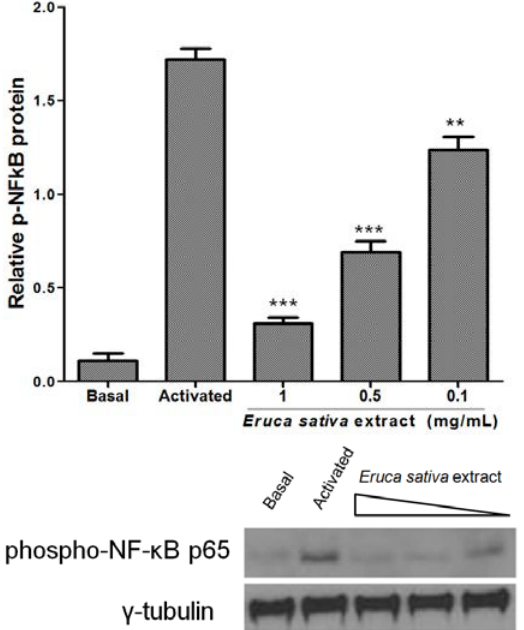
Figure 5. Effect of Eruca sativa Mill. extract on phospho-NF-κB p65 in activated platelets by ADP (8 μmol/L). Washed platelets were collected, and subcellular extracts were analyzed for phospho-NF-κB p65, as described in the Experimental Section. Data are presented as the mean ± SEM of n = 6 experiments. ** p < 0.01 and *** p < 0.001 indicates differences between activated and Eruca sativa Mill. extract groups as analyzed by one-way ANOVA and Tukey’s post hoc test.